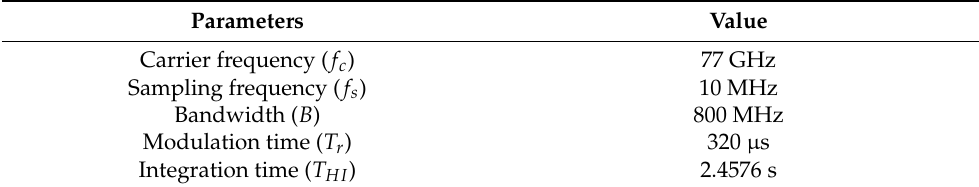
Table 3. Main parameters of the FMCW